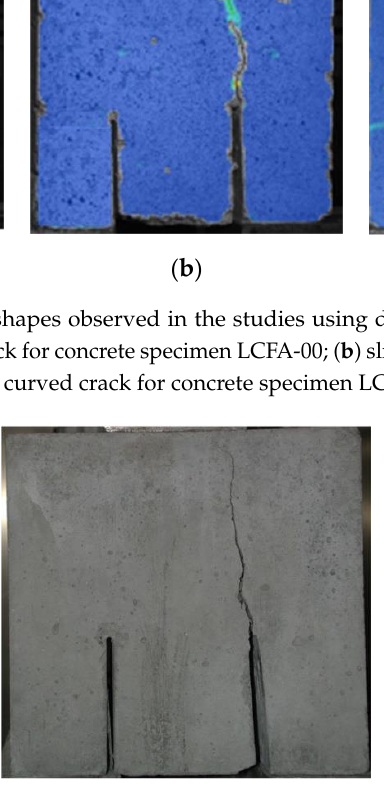
Figure 12. Characteristic crack path observed in the tests.